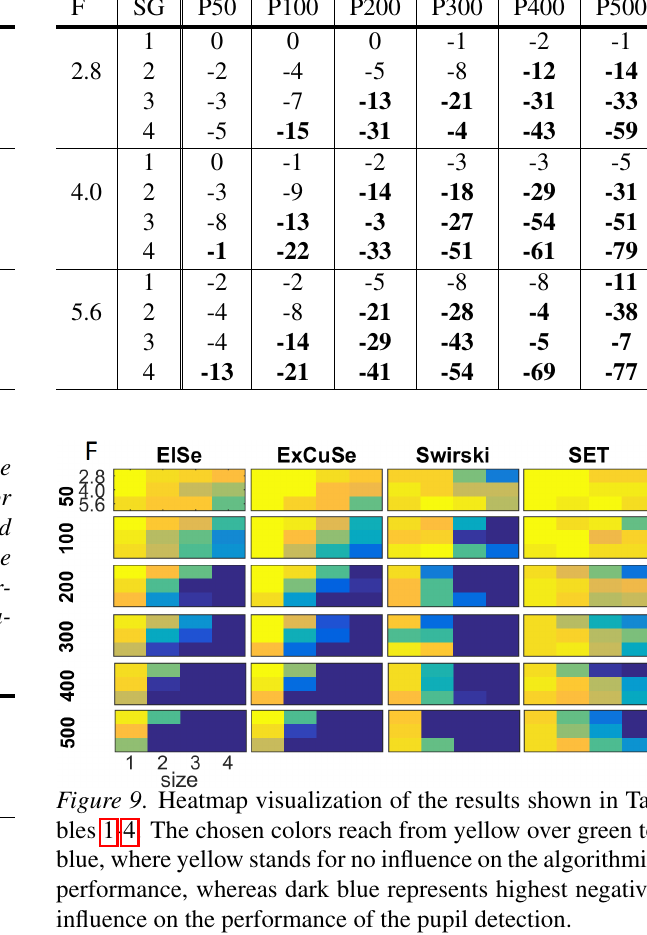
Performance of the ElSe algorithm. The results show the re- duction in detection rate (in %) due to dirt for an error rate of 5 pixels. The baseline are detection rates achieved on clean images. F represents the focal length, SG the size group, whereas P50-P500 values specify the amount of particles. Bold highlights a reduction in the detection rate relatively to clean data of more than 10%.